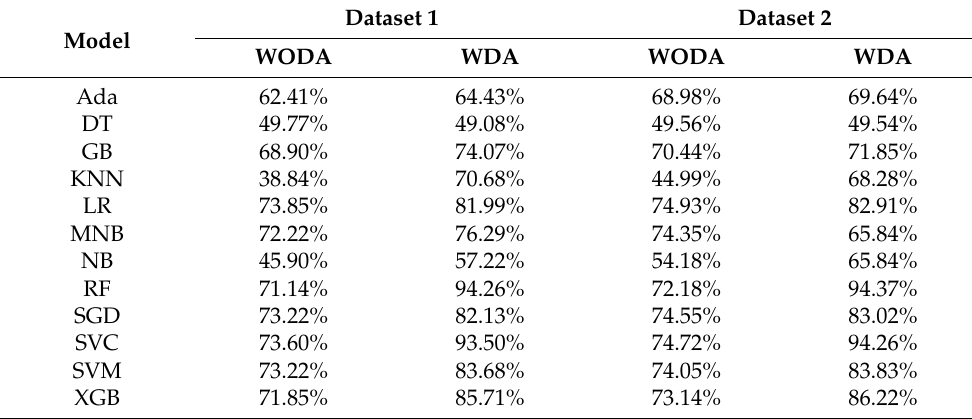
Table 8. F1-Score using ML classifiers.